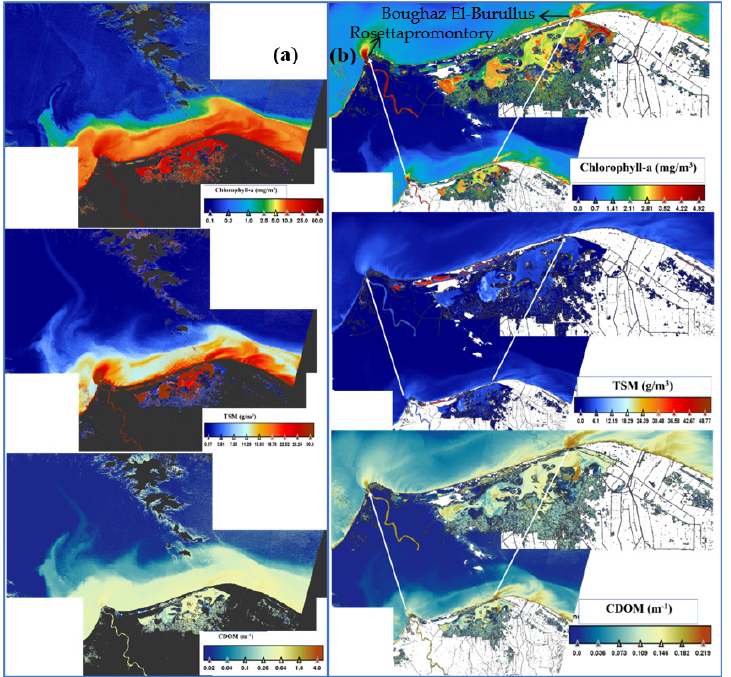
Figure 4. Retrieved water color parameters from S2MSI of ( a ) Chl- a , TSM, and CDOM, and ( b ) as- sociated errors. ated